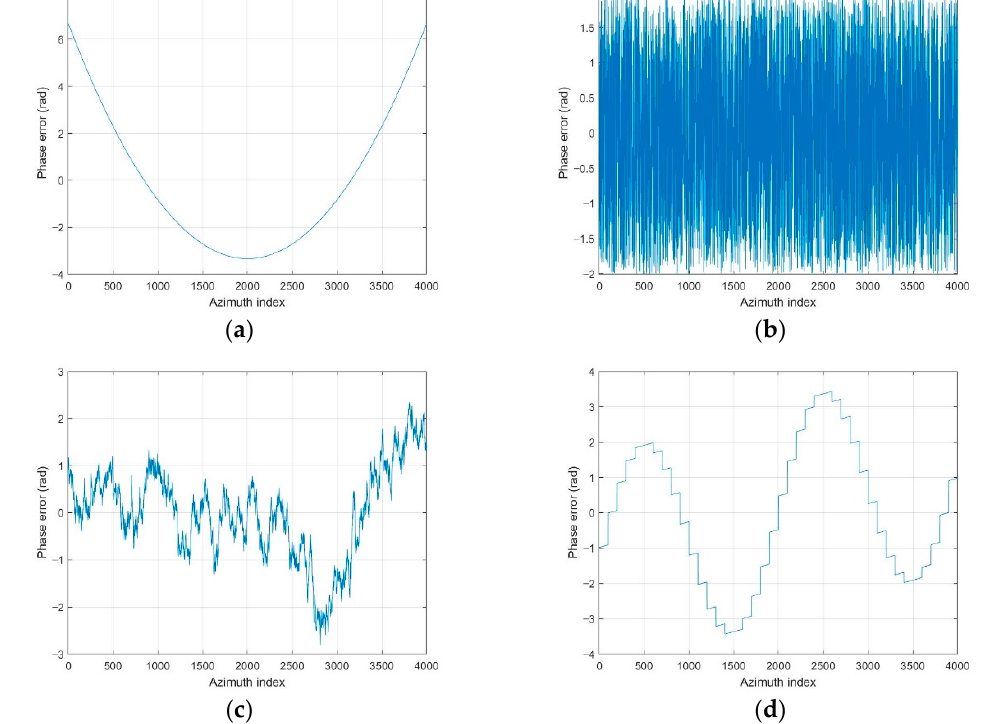
Figure 6. Phase errors to verify the performance of the autofocus algorithms. ( a ) Quadratic error. ( b ) Uniformly distributed random error. ( c ) Wiener process error. ( d ) Sinusoidal error with